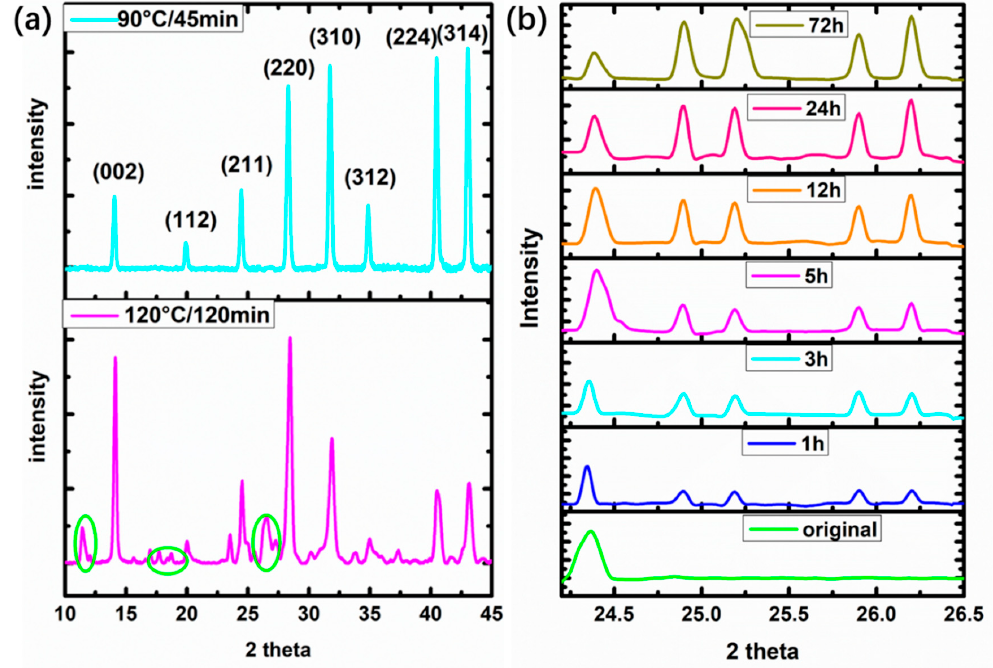
Figure 2. ( a ) The results of XRD measurements for CH 3 NH 3 PbI 3 synthesized from various precursor solutions, including 90 ◦ C / 45min and 120 ◦ C / 120min; ( b ) In situ XRD results of CH 3 NH 3 PbI 3 thin film under methanol environment.